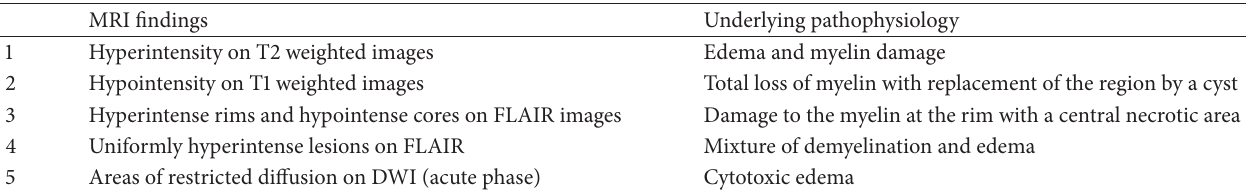
Table 2: Correlation of imaging findings in MBS with pathophysiology [1,